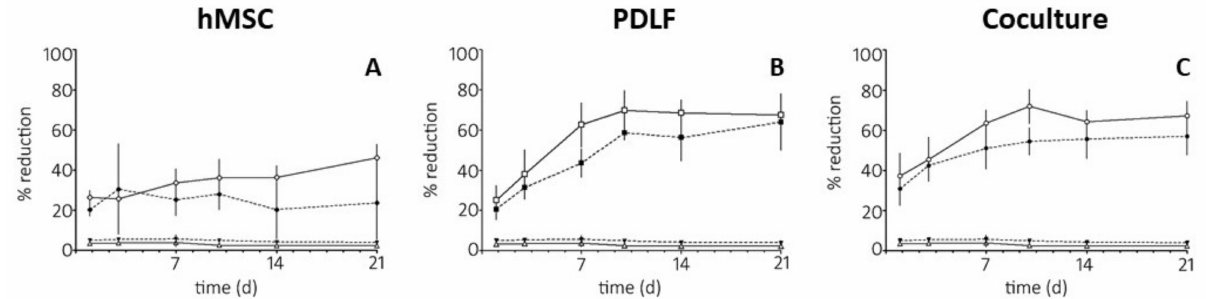
Figure 5. Line graphs representing the metabolic activities of hMSCs, PDLFs, or cocultures of both cell types on eGHA or eGHA ap . The resazurin/Alamar Blue ® activity assay was used to determine the reductive activity of the cells, which is an indirect measure for cell viability and metabolism. The indicated cells were incubated on the scaffolds for 1, 3, 7, 10, 14, and 21 d. Completely reduced Alamar Blue ® reagent was used as a positive control (=100%). eGHA (black triangles) and eGHA ap (white triangles) without cells were used as negative controls for all experimental conditions. Mean metabolic activities and the corresponding standard deviations (SD) are depicted. The numerical data are presented in Supplementary Table S3. ( A ) Comparison of the reductive capacity of hMSCs grown on eGHA (black rhombs) and eGHA ap (white rhombs). ( B ) Comparison of the reductive capacity of PDLFs grown on on eGHA (black squares) and eGHA ap (white squares). ( C ) Comparison of the reductive capacity of interactive cocultures grown on eGHA (black circles) and eGHA ap (white